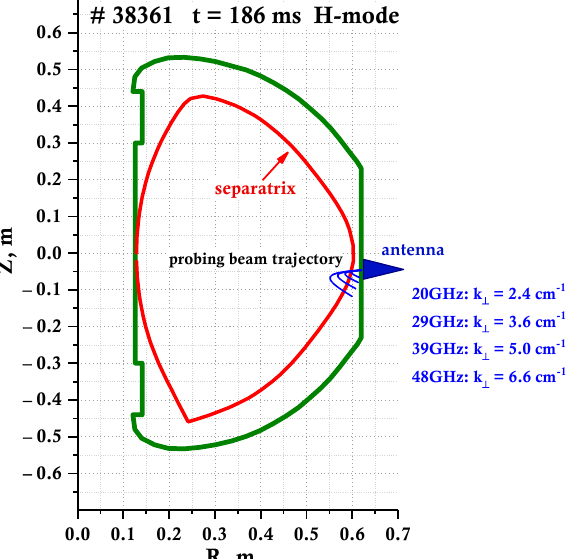
Figure 2. Ray tracing for the four-frequency DBS system used to study the LH transition.